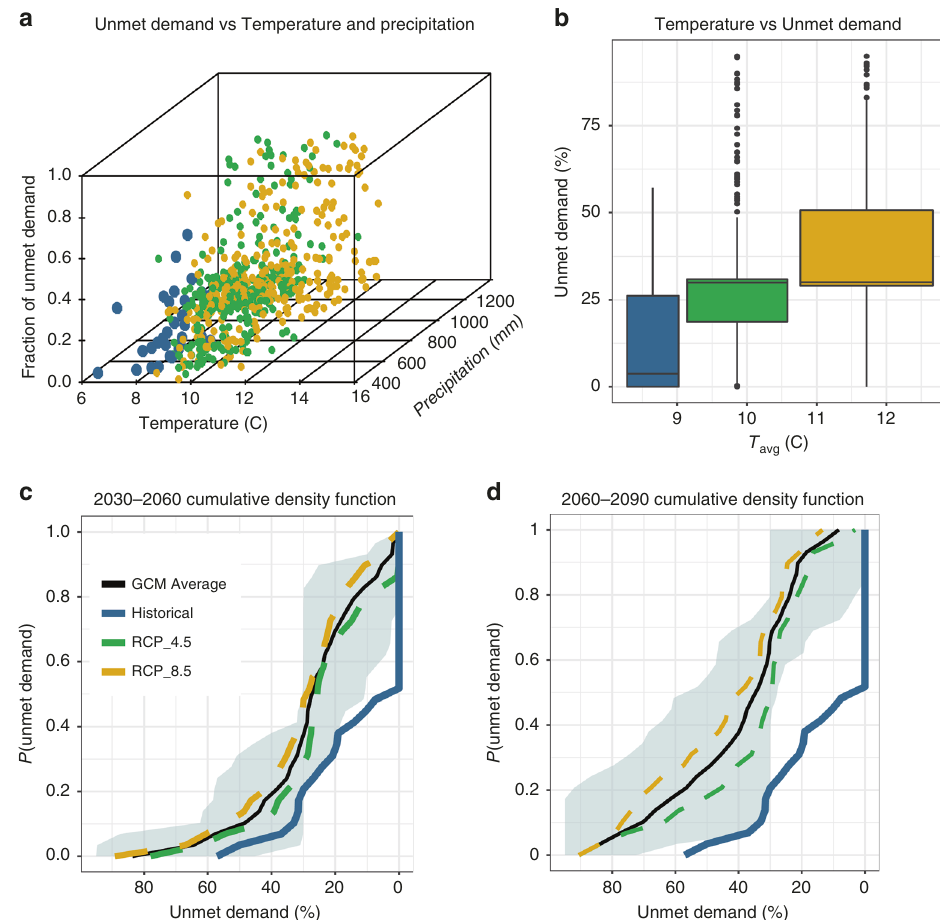
Fig. 1 Impacts of climate change on water stress for irrigated agriculture. Panel a shows how unmet demand (UD) responds to temperature and precipitation. Each point corresponds to 1 year of simulation from one of the fi ve GCMs used in this study. The historical period is from 1980 – 2010 and the future period is from 2030 – 2090. Panel b shows how unmet demand responds to temperature. In panels b , the interquartile range in the boxplots is 50% (lower and upper quartile limits are 25% and 75%, respectively). The middle line in the boxplot represents median, and the whiskers can span to 1.5 times the upper and lower interquartile ranges. Outliers (points) in this fi gure are numbers outside the whiskers. Also, in panel b , n = 300 simulated annual yield values for RCP 8.5 and 4.5 boxplots, and n = 30 simulated annual yield values for the historical boxplots. Panels c and d show cumulative density functions of the unmet demands for 2030 – 2060 and 2060 – 2090, respectively. Light shading in panels d and e represents the variation among GCMs and RCPs. Source data are provided as a Source Data fi